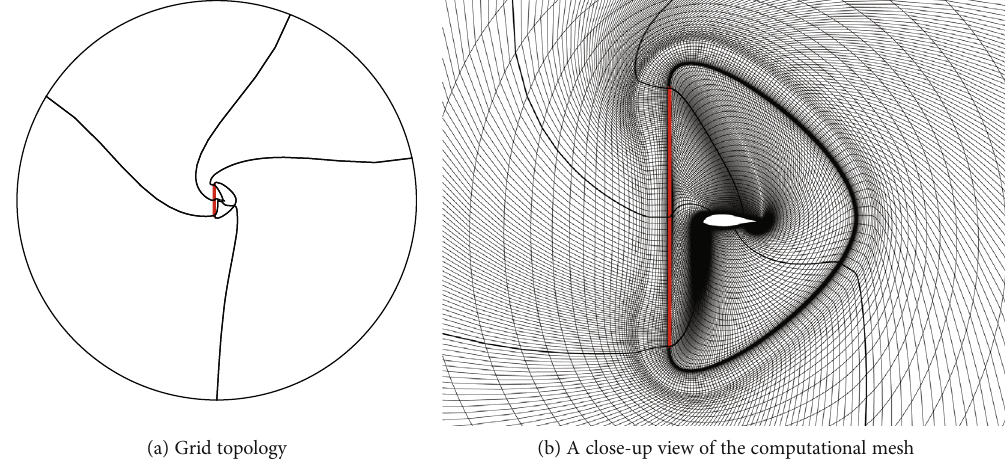
Figure 9: Pregenerated 2D multiblock grid at θ = 90 °